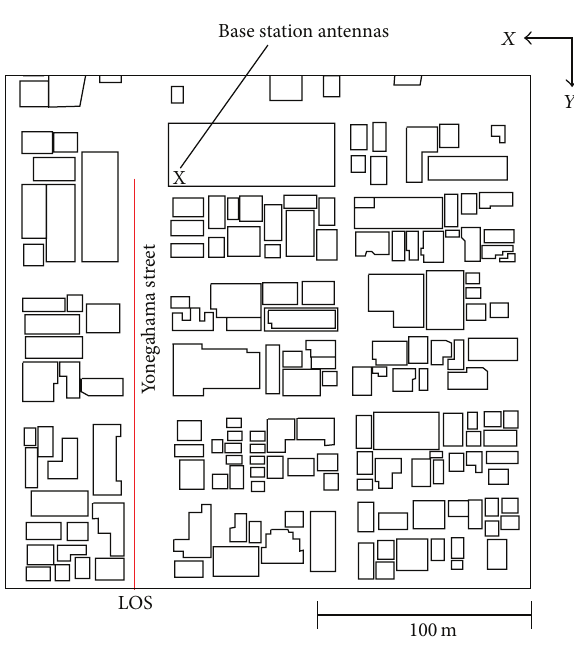
Figure 16: Map of measurement